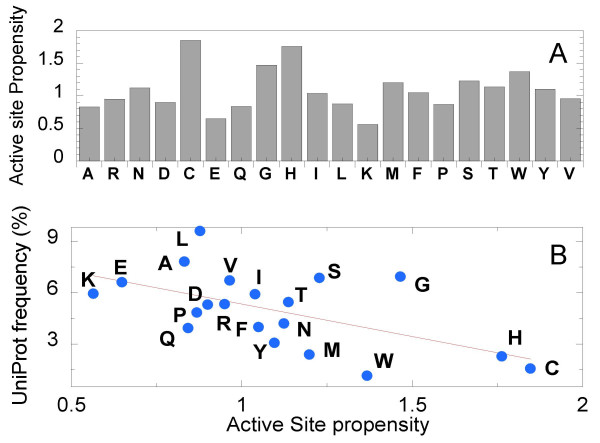
Active site propensity of amino acids and comparison with their natural frequencies. (A) For each type of amino acids, the frequencies of occurrence in the active and non-active sites were calculated. The ratio between them is defined as the active site propensity (ordinate). (B) Natural (UniProt) frequency of occurrence vs. active site propensity for each type of amino acid. Less frequent amino acids tend to have a higher active site propensity, and vice versa, in accord with the histograms in Figure 4. This effect becomes more pronounced at the level of 3-grams.